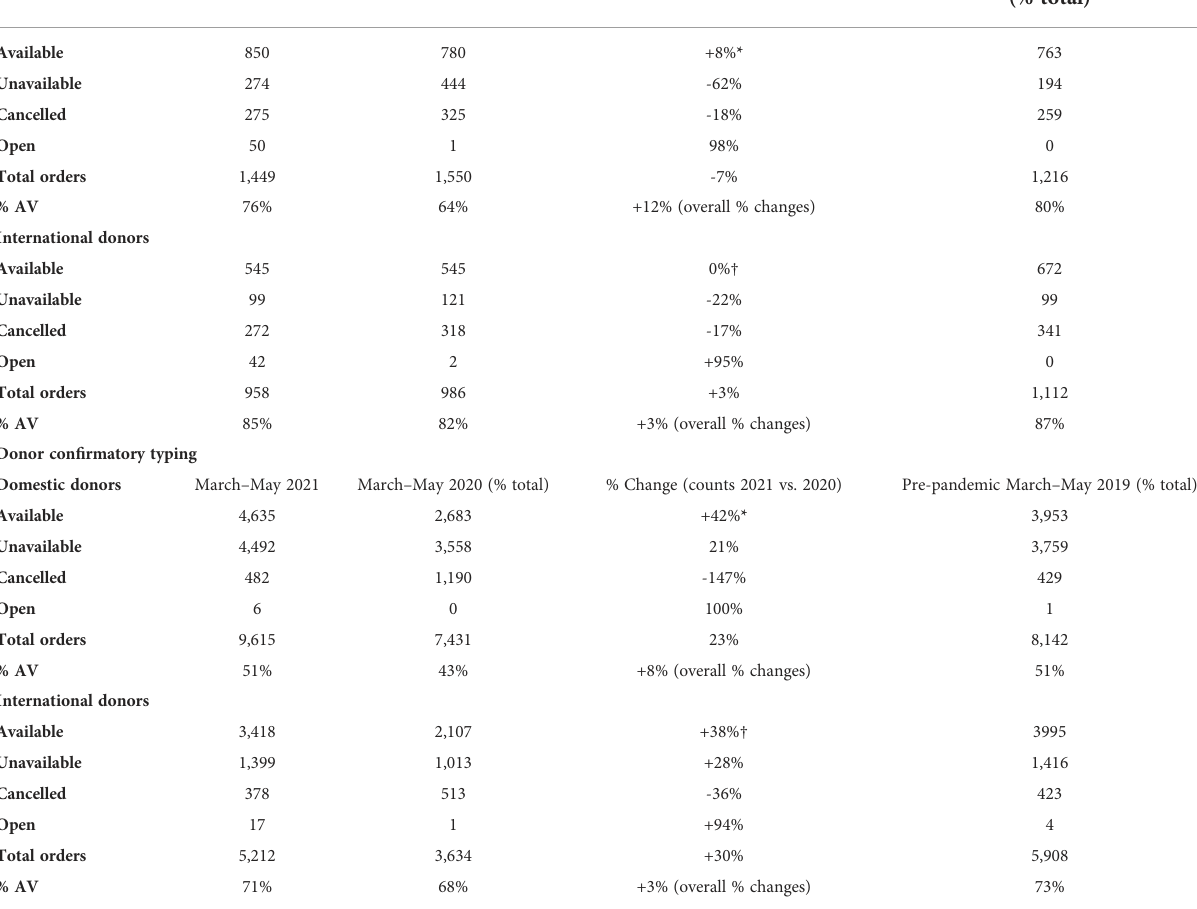
TABLE 2 Donor availability at the time of workup and con fi rmatory